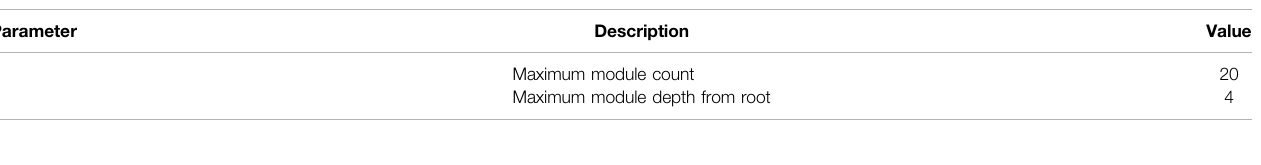
Table A1 | Morphological parameters for the evolved modular robots.